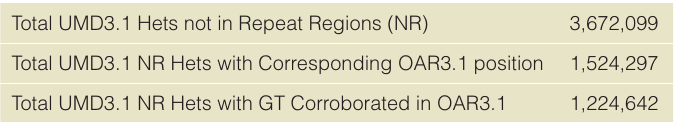
Table 1. List of the number of variants identified in UMD3.1 for which a corresponding position could be identified in Oar3.1, and of these the number of variants whose genotype was corroborated (80.3%) vs. Oar3.1. No variants identified on the X-chromosome of either reference were included in these